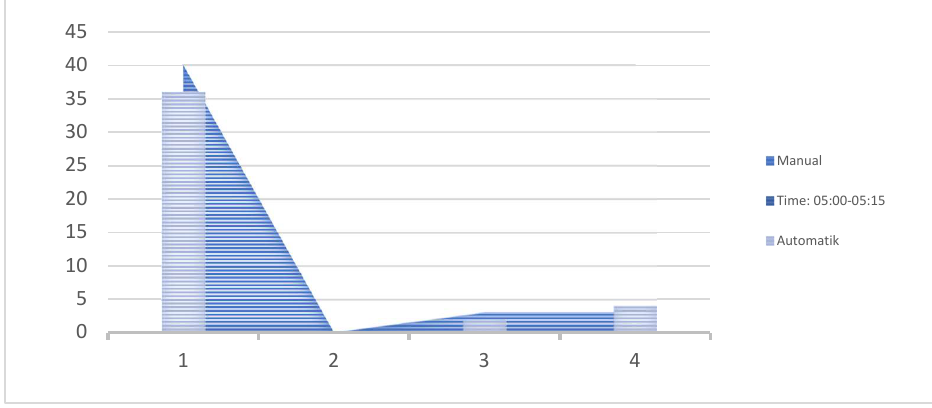
Figure 10. Difference between automatic and manual counts of vehicles (time 05:00–05:15).